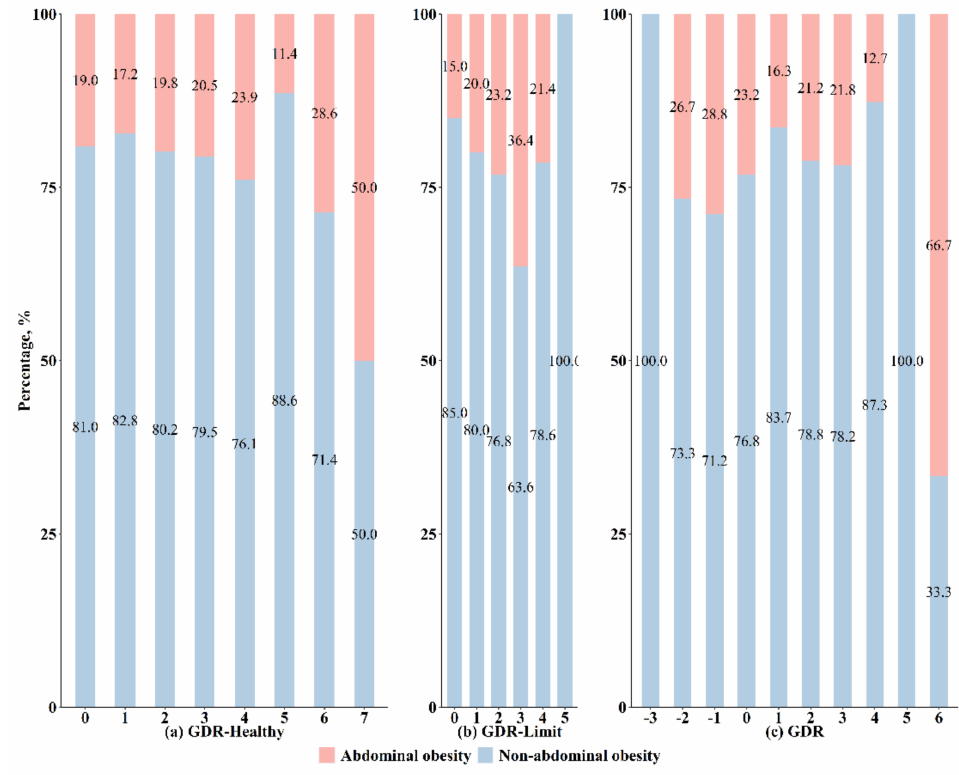
Figure 4. Prevalence of abdominal obesity by Global Dietary Recommendations (GDR) scores. Table 2. Associations of Global Dietary Recommendations scores with overweight and